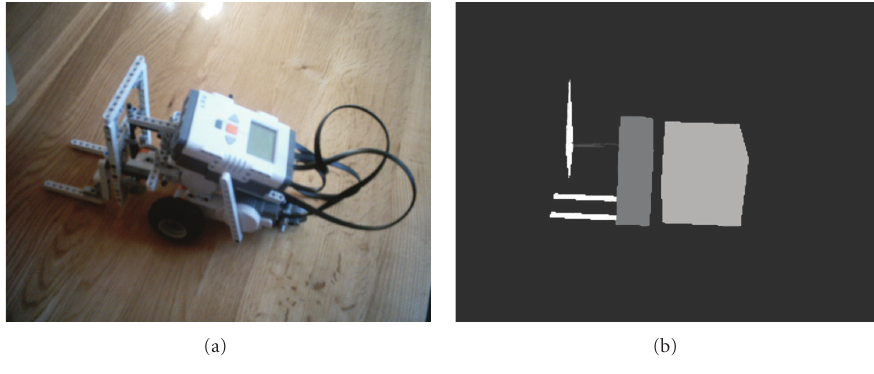
Figure 3: A real robotic forklift and its physics proxy.